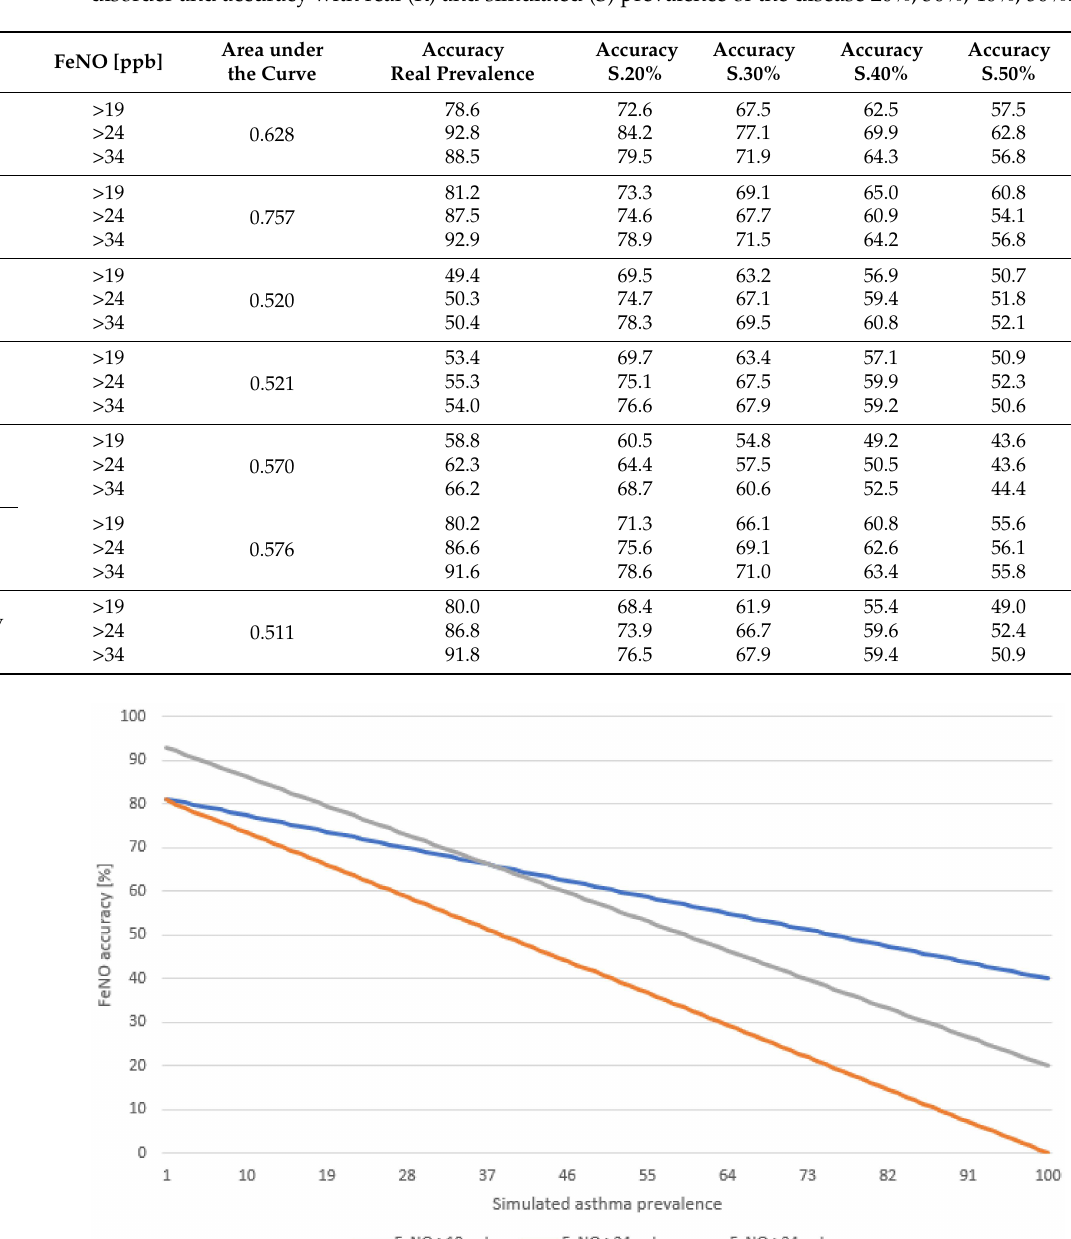
Table 2. Diagnostic accuracy expressed as area under the curve, accuracy with a known prevalence of